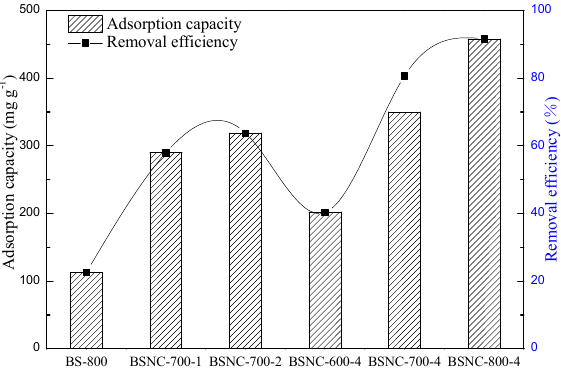
Figure 4. The adsorption capacity and removal efficiency of BSNCs; left y-axis represents the adsorption capacity, right y-axis represents the removal efficiency.